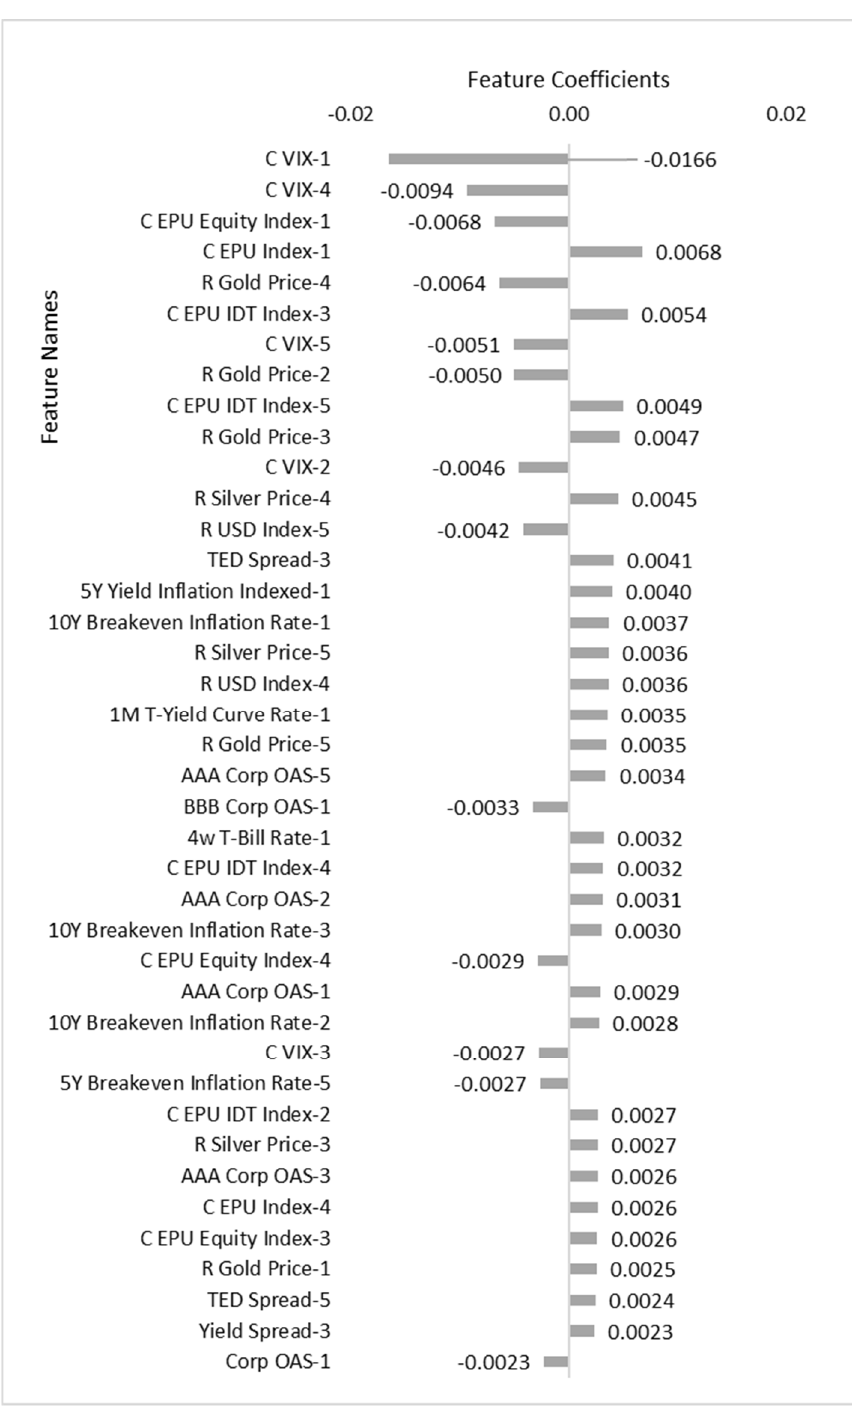
Figure 7. Top forty daily ranked features from logistic regression. The displayed numbers, truncated to four decimal places, are the features’ coefficients.